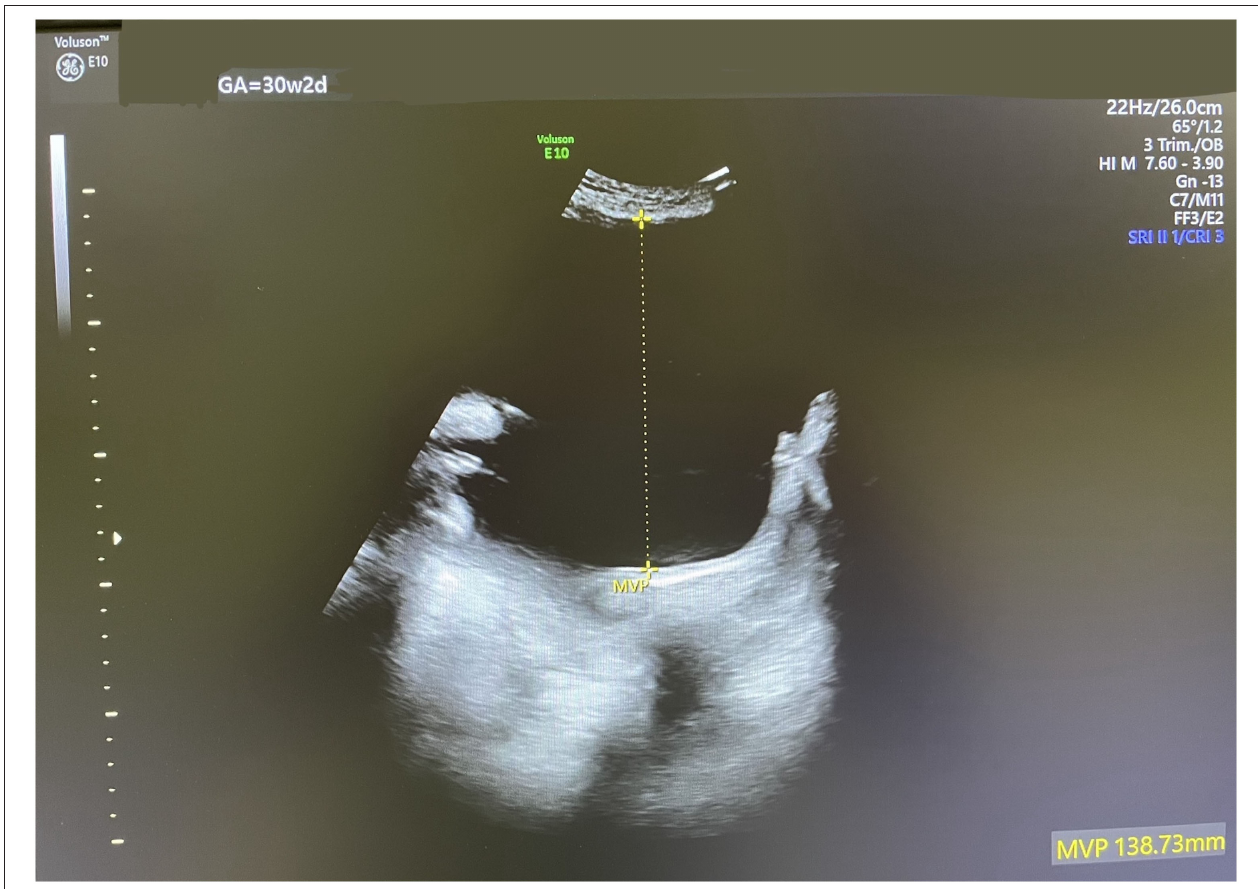
FIGURE 1 | An ultrasound scan showing severe polyhydramnios with a single DVP of 13.9cm at 30 weeks and 2